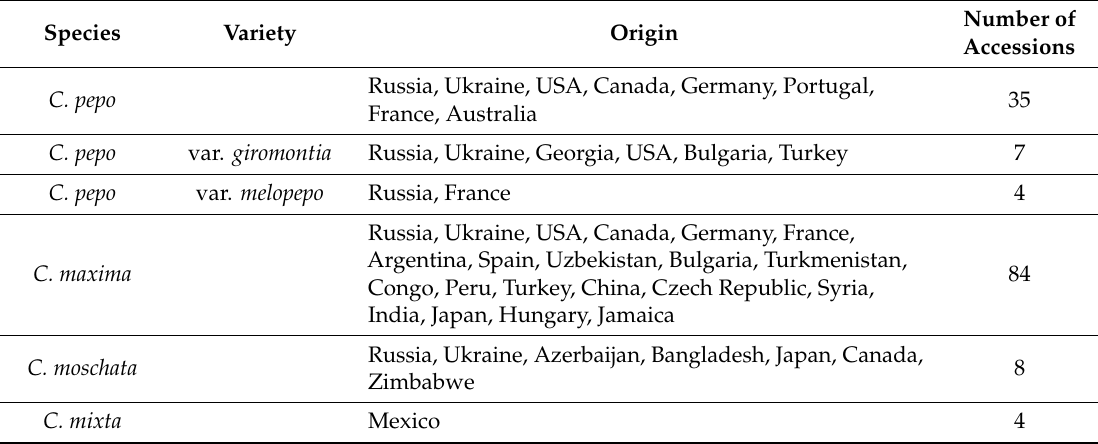
Table 1. List of Cucurbita L. species from the VIR collection used as a research material.